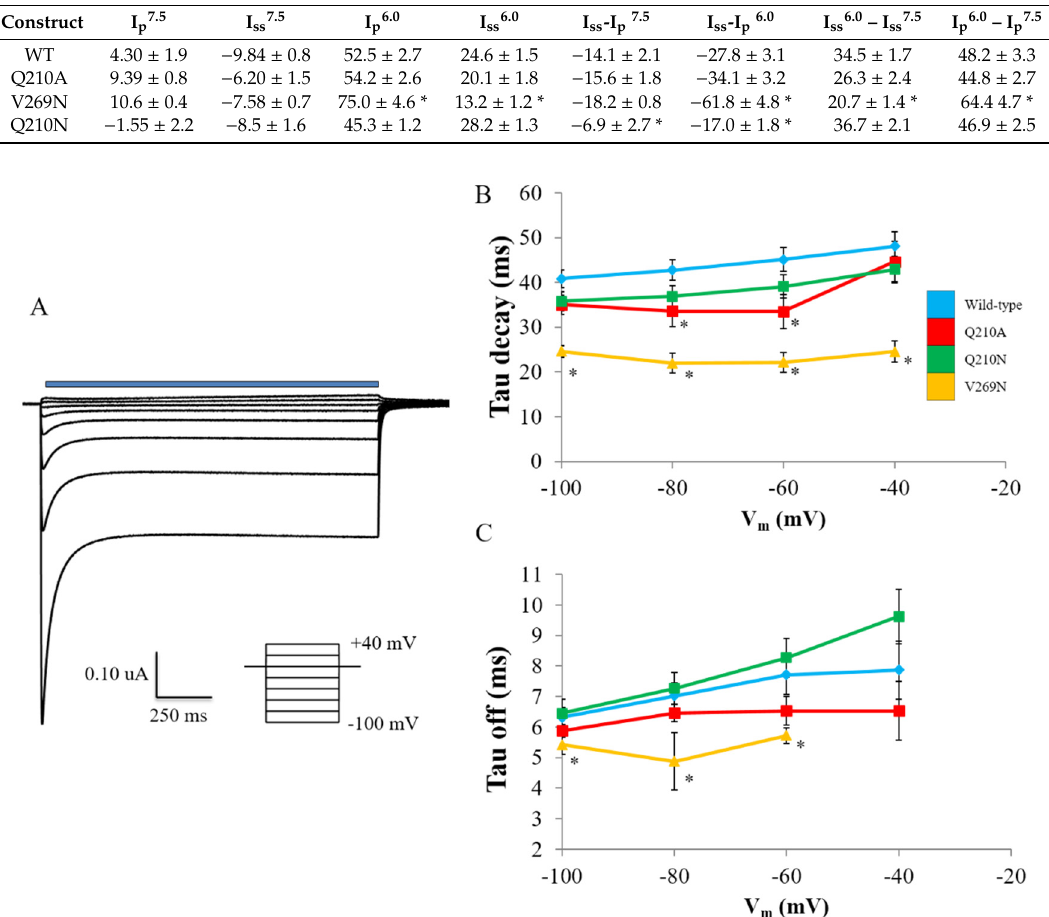
Figure 5. Kinetic properties of RHM-affecting mutants. ( A ) Summary of exponential fitting of apparent rate constants. ( B ) Decay rate comparison of RHM-affecting and null ChR2 mutants. ( C ) Off rate comparison of RHM-affecting and null ChR2 mutants. Error bars represent the SEM (n = 7–15). Statistically significant differences are denoted by * (p < 0.05). WT—blue; Q210A—red; Q210N—green; V269N—orange. Table 2. Summary of reversal potentials. The superscript denoted the pH of the solution used. Values are reported at the average ± SEM (n = 7–15). Statistically significant values are denoted with * (p < 0.05).